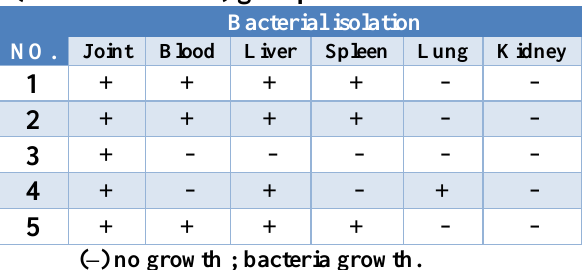
Table,1: Bacteria:l isolation from the blood, joint and internal organs of the 1st (non immunized) group.